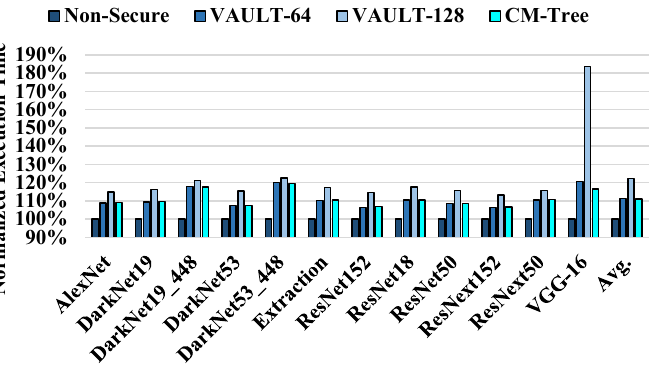
Figure 11. Normalized execution time for VAULT-64, VAULT-128, and Countermark-tree.